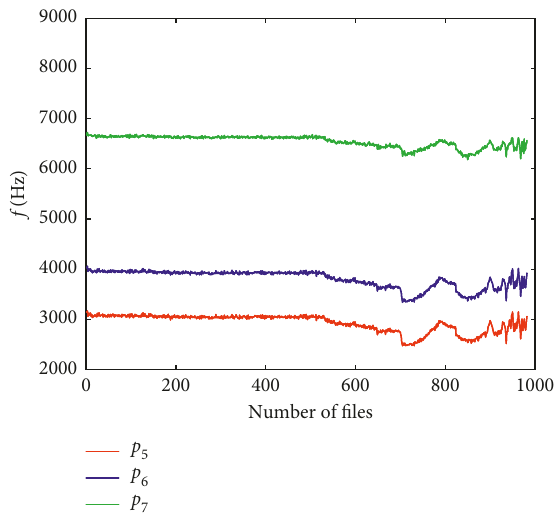
Figure 12: The p 5 , p 6 , and p 7 of Case I processed after envelope analysis.